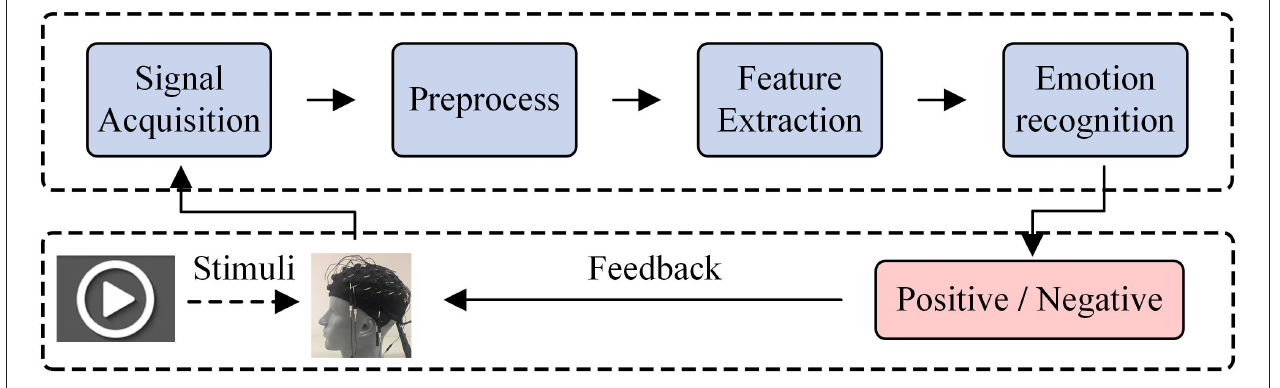
FIGURE 1 | A general EEG-based aBCI.